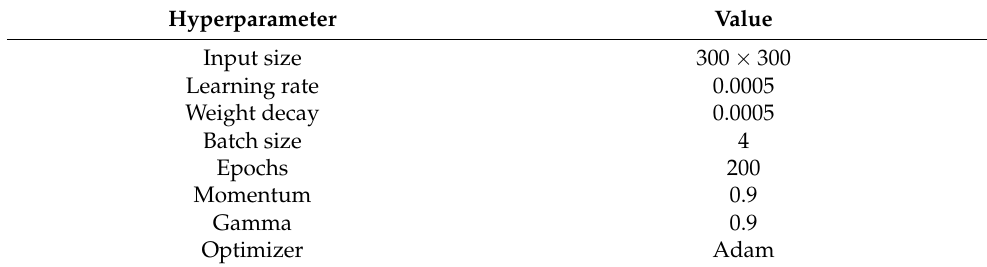
Table 2. Model training